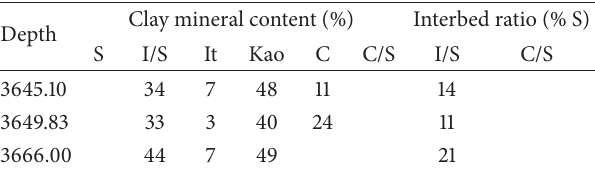
Table 4: Clay mineral composition and content of the Nahr Umr Shale.